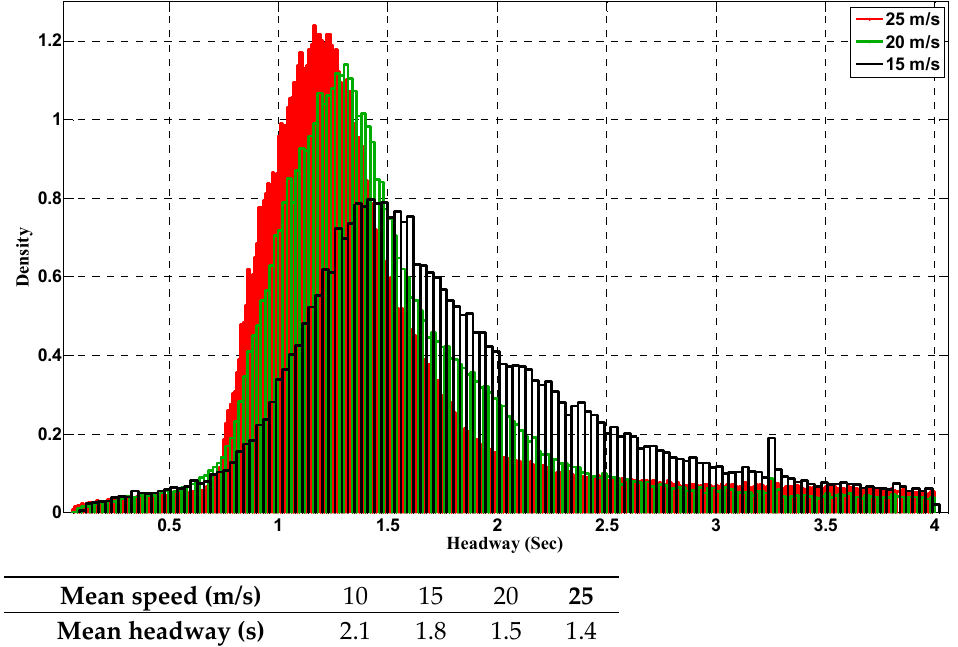
Figure 8. Headway distribution in the SBM CF simulation for different range of speed.